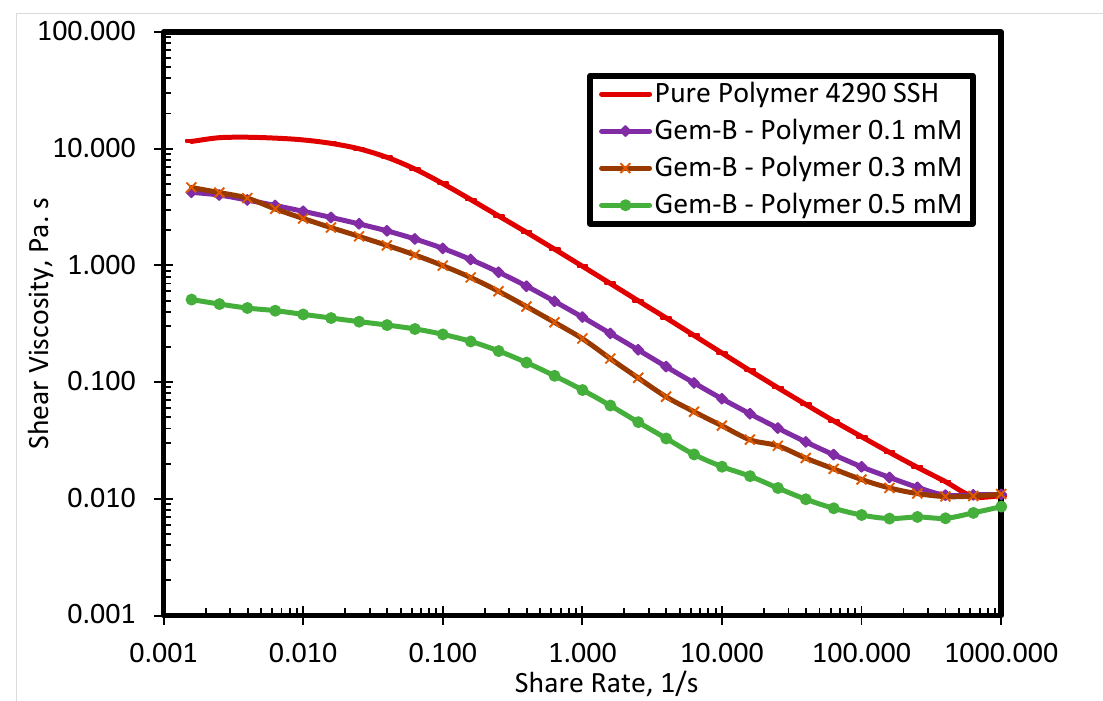
Figure 7. Shear viscosity of 4290 SSH polymer with Gem-B surfactant at different concentrations.